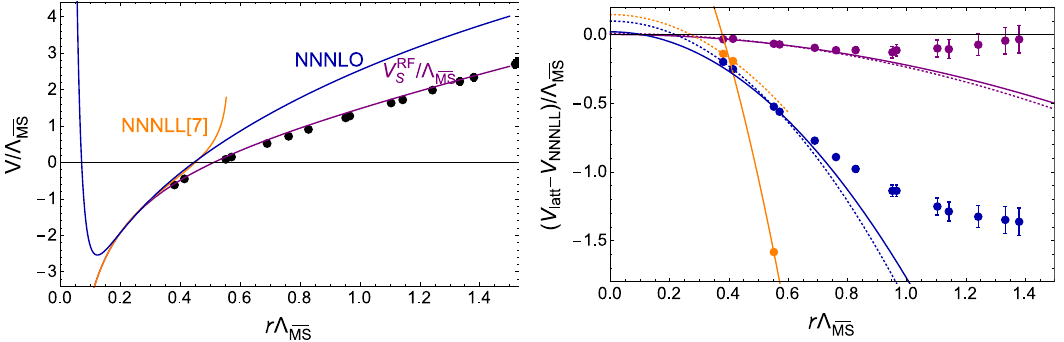
Figure 9 . (Left) Static potentials obtained from lattice (black), V RF = (cid:3) (purple), the N 3 LL S MS prediction of ref. [7] (orange), and the (cid:12)xed order N 3 LO prediction with (cid:3) =(cid:22) = 0 : 4 (dark blue). MS (Right) Di(cid:11)erences between the lattice result and the theoretical predictions. Purple data represent the di(cid:11)erence from V RF , the orange ones from the N 3 LL prediction of ref. [7], and the dark blue ones S from the N 3 LO prediction. The curves in this (cid:12)gure are const.+const. (cid:2) r 2 functions determined by (cid:12)ts. The purple solid line is determined with the (cid:12)rst six points [ (cid:31) 2 = d : o : f : = 2 : 5 = (6 (cid:0) 2)], and the purple dotted one with the (cid:12)rst three points [ (cid:31) 2 = d : o : f : = 0 : 19 = (3 (cid:0) 2)]. The orange solid line is determined with the (cid:12)rst three points [ (cid:31) 2 = d : o : f : = 85 = (3 (cid:0) 2)], and the orange dotted one with the (cid:12)rst two points [d : o : f : = 0]. The dark blue solid line is determined with the (cid:12)rst six points [ (cid:31) 2 = d : o : f : = 141 = (6 (cid:0) 2)], and the dark blue dotted one with the (cid:12)rst three points [ (cid:31) 2 = d : o : f : = 0 : 002 = (3 (cid:0) 2)].